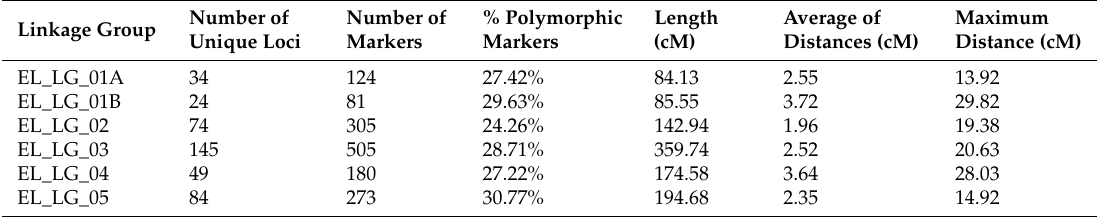
Table 3. Summary of ExL genetic linkage maps constructed based on 4601 markers in Lupinus angustifolius . Linkage